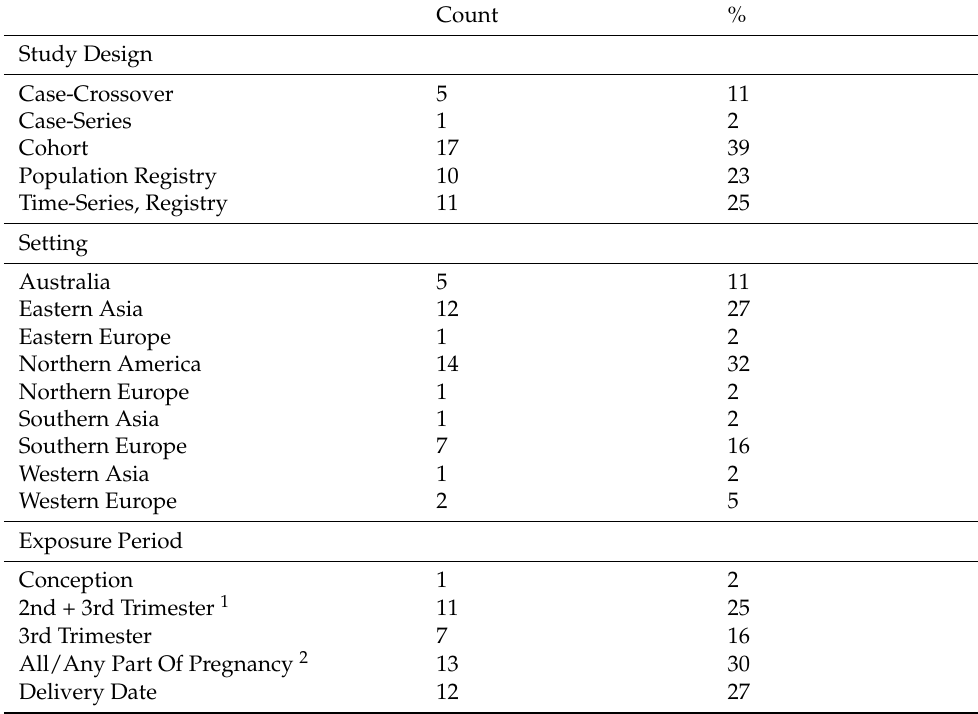
Table 3. Preterm Birth Study Characteristics n = 44.